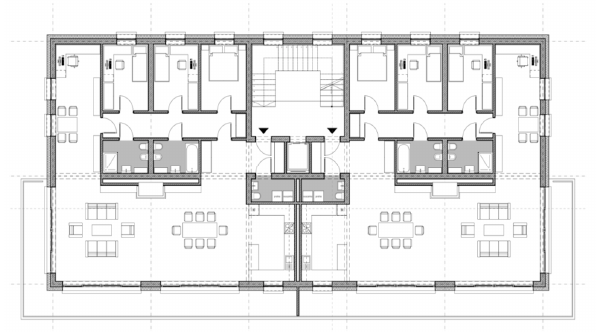
Figure 2. Repetitive floor plan for residential use, including: entrance hall, toilet and laundry room, parents’ bedroom, two children’s rooms, two bathrooms, an open office and a library, a large day section and an open kitchenette enabling good access to daylight and solar gains during winter (low incidence angle of solar rays).